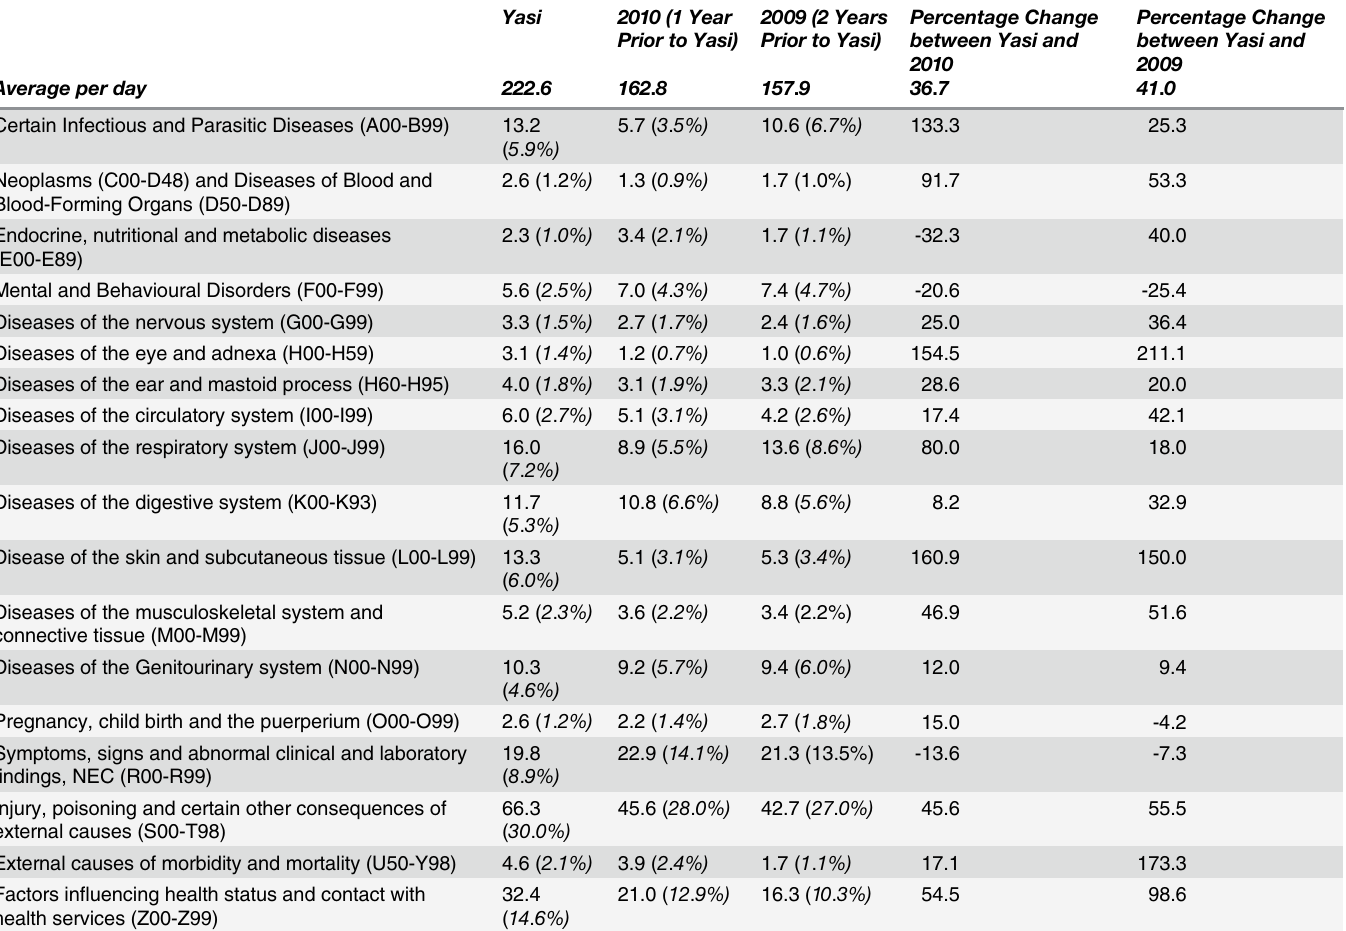
Table 3. Average presentation per day during Yasi and years prior by ICD-10-AM group classifications, 31-Jan-2011 to 8-Feb-2011, TTH